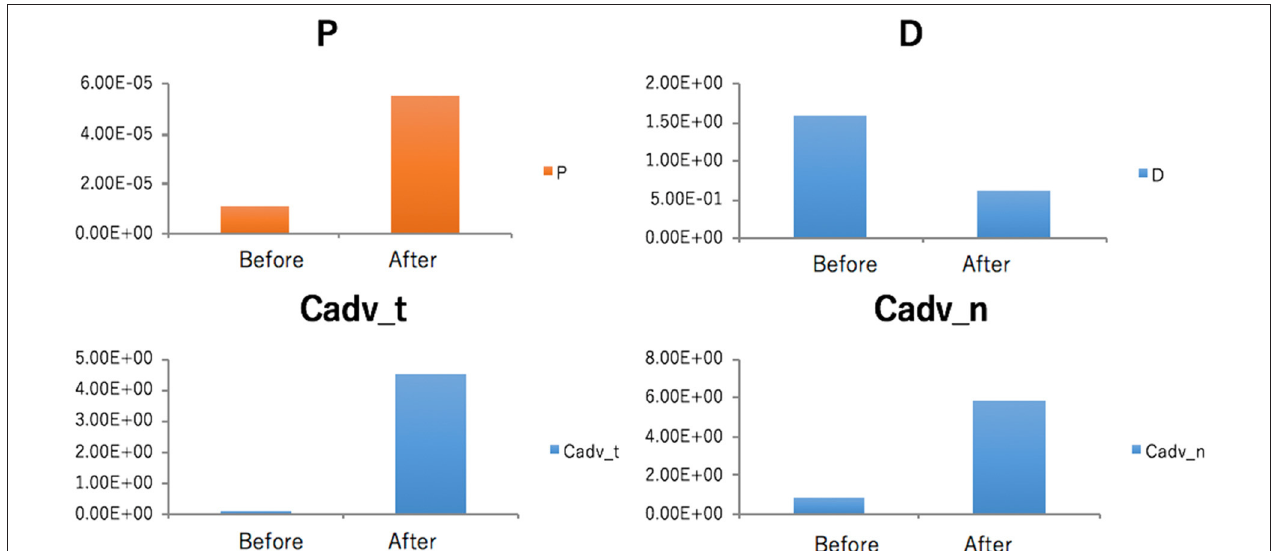
FIGURE 5 | Observed parameters “P,” “D,” and C adv for TV, and C adv for the internet, as per the calculations in of Figure 4 .